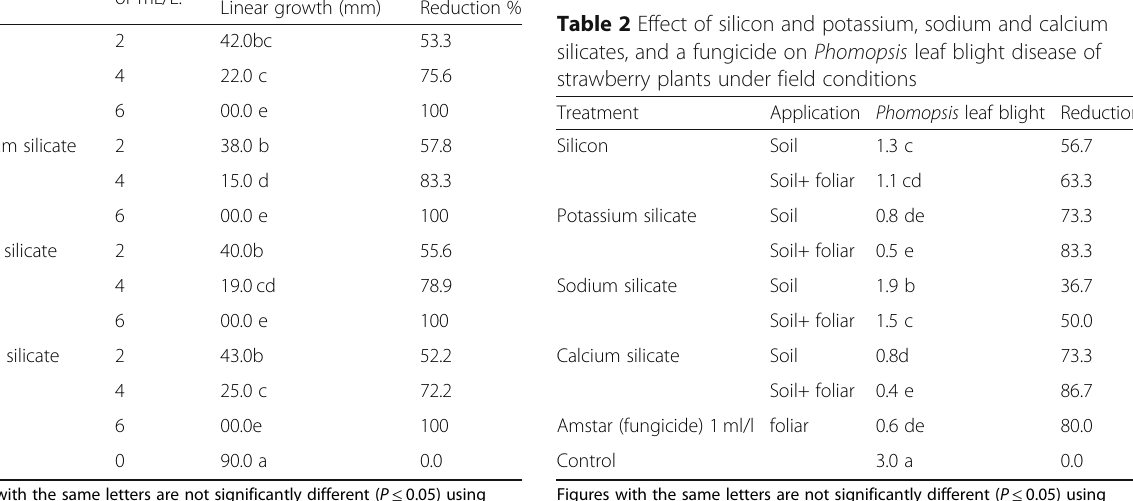
Table 1 Effect of silicon and potassium, sodium, and calcium silicates on linear growth of Phomopsis obscurans under laboratory conditions Treatment Conc. g or mL/L.